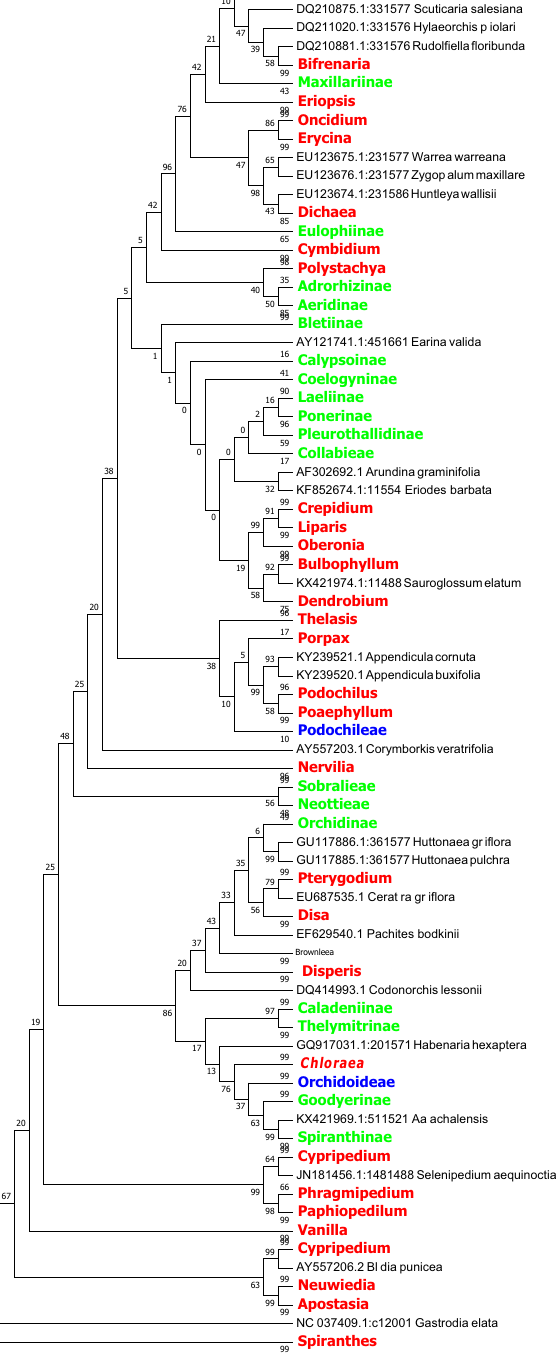
Figure 2. The NJ tree of Orchidaceae coming from analysis of the cp DNA matK sequence based on the K2P model. Names tagged in red indicates the genus, tagged in green showed the subtribe and tagged in blue showed the subfamily; The Numbers on the branches represent more than or equal to 50 percent support after the 1000 bootstrap replications test; Numbers following taxon names showed the number of